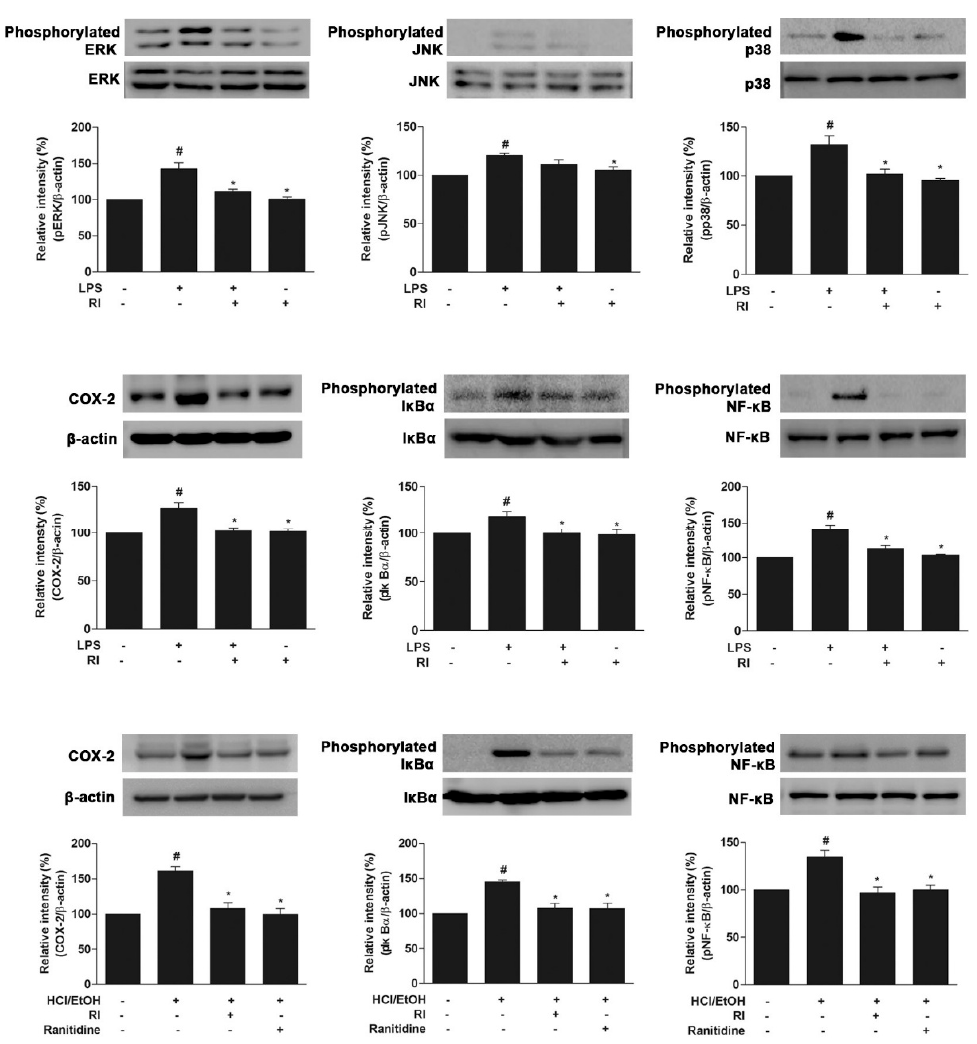
Figure 6. Protective role of RI on the MAPK cascades, COX-2 expression, and activation of I κ B α , NF- κ B in RAW 264.7 cells and gastric tissue. Here, upper and middle panels represent the MAPKs (pERK1/2, pJNK, and pp38), COX-2, I κ B α and NF- κ B expression in RAW 264.7 cells and the lower panel represents the COX-2, I κ B α and NF- κ B expression in the gastric tissue. The relative band intensity of target protein was measured as compared with total protein and β -actin. LPS-induced the phosphorylation of MAPK cascade, whereas pretreatment with the RI reduced the phosphorylation of MAPK cascade. LPS and HCl/EtOH increased the COX-2 expression, kinetic phosphorylation, and degradation of I κ B α and phosphorylation of NF- κ B. However, pretreatment with the RI notably decreased the COX-2 expression, I κ B α phosphorylation, and degradation, NF- κ B translocation as related to standard drug ranitidine. # p < 0.05 when compared with the control and * p < 0.05 when compared with LPS and HCl/EtOH. Data are expressed as mean ±